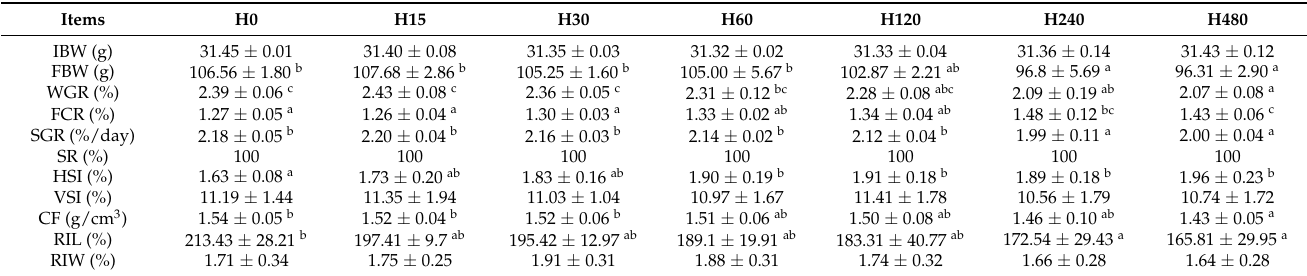
Table 4. Effect of dietary histamine on growth performance and morphologic indexes of striped cat- fish.